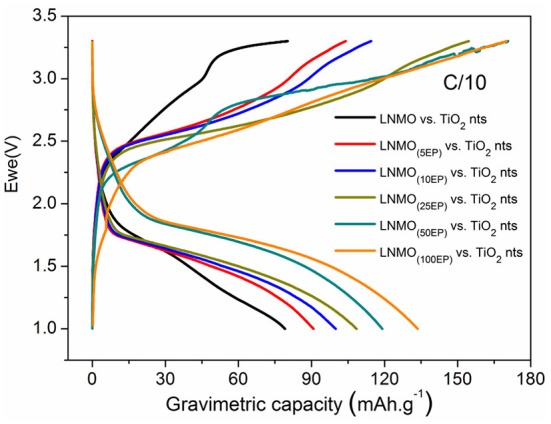
First reversible charge/discharge capacities for LNMO(EP) vs. TiO2 nts at C/10 in the potential range of 1–3.3 V.